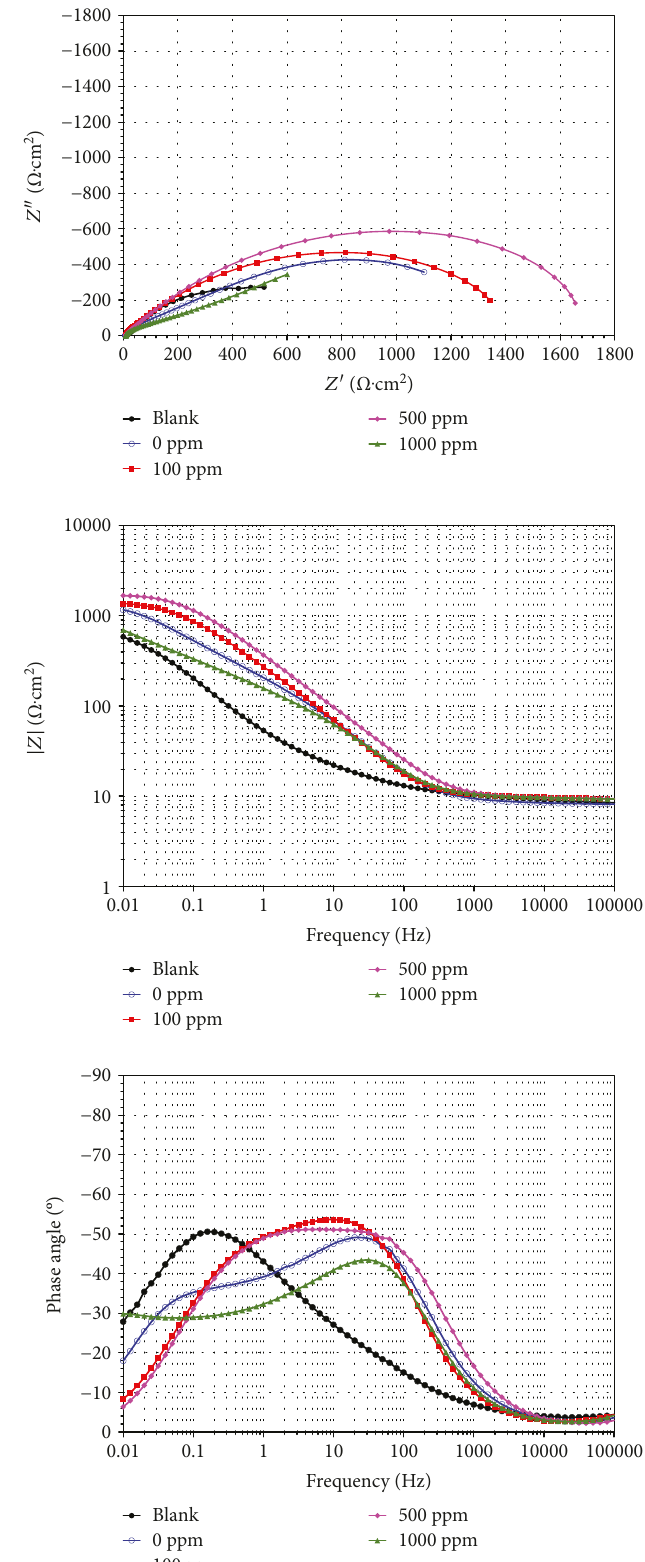
Figure 11: Nyquist and Bode diagrams for 1018 carbon steel bare and coated with chitosan doped with Nd hours of immersion in 3.5% NaCl